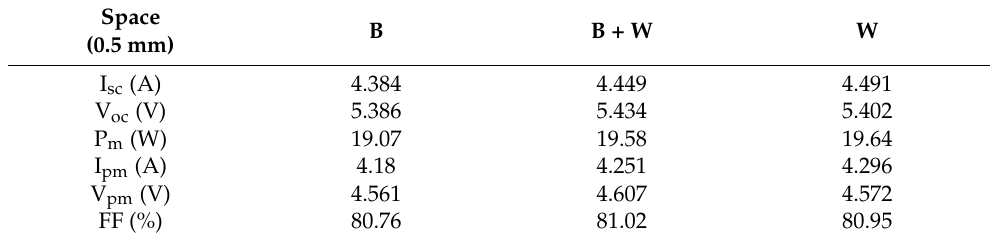
Table A1. The summary of MBB module operating test with various backsheets with 0.5 mm gap space.